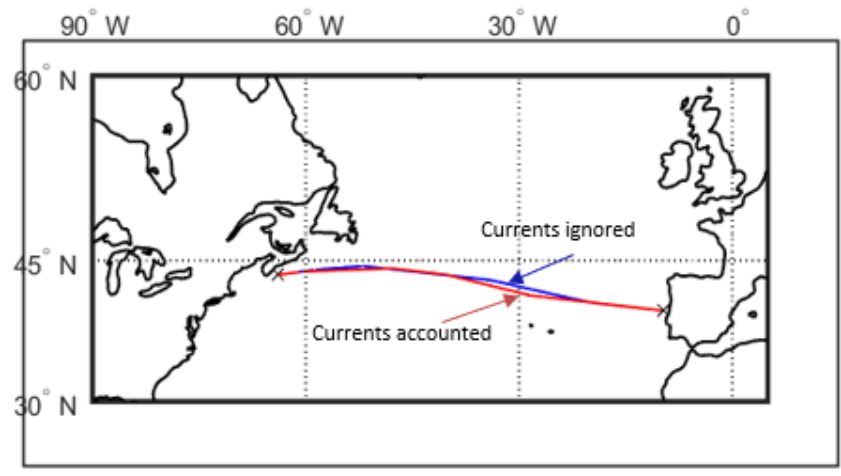
Figure 14. Optimal paths with (red route) and without (blue path) the currents’ effect.